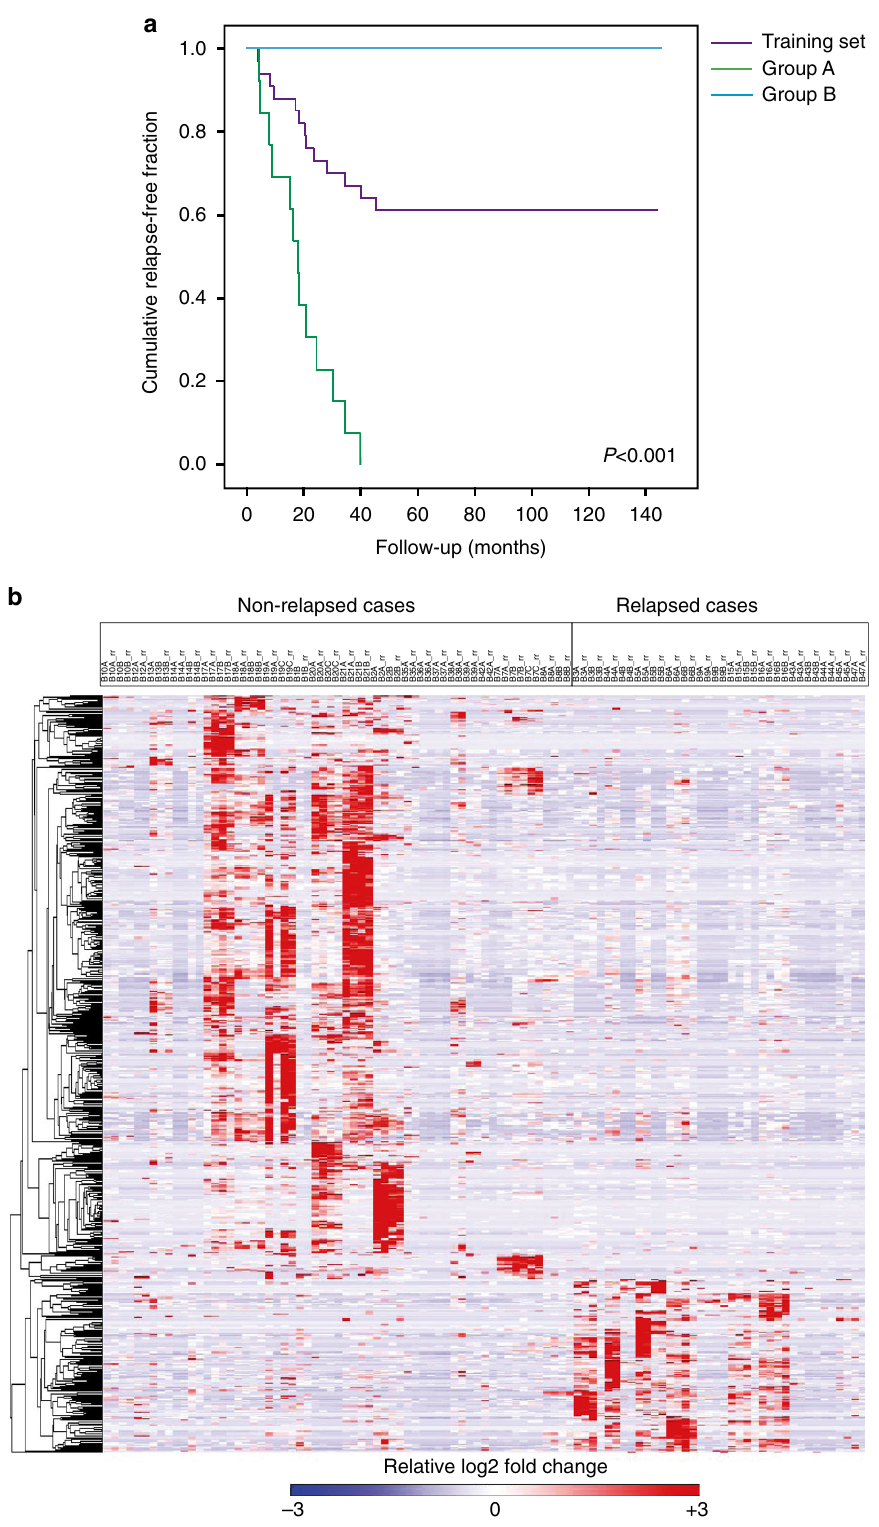
Fig. 1 Phosphopro fi ling of the patient training set. a There were two patient subgroups in the training set: A 13 patients who relapsed within <3 years after locoregional treatment (green chart), and B 21 patients who did not relapse >10 years after locoregional treatment (blue chart). The graphic shows the Kaplan – Meier curves of the training set as a whole (purple chart) and of the two subgroups. Median time to relapse in group A: 17.4 months; median time to relapse in group B: not reached (log-rank test, p < 0.001). b The heatmap shows the phosphopeptides ( n = 702: 543 upregulated in non-relapsed and 159 upregulated in relapsed patients) with signi fi cant differences in phosphorylation levels in tumors from the training set by relapse status